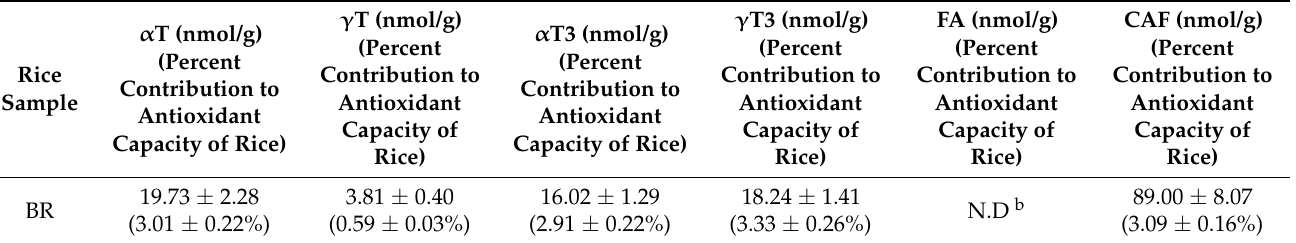
Table 1. The concentrations of the major phytochemicals in the brown rice and their percent contribu- tion to the antioxidant capacity of whole brown rice a